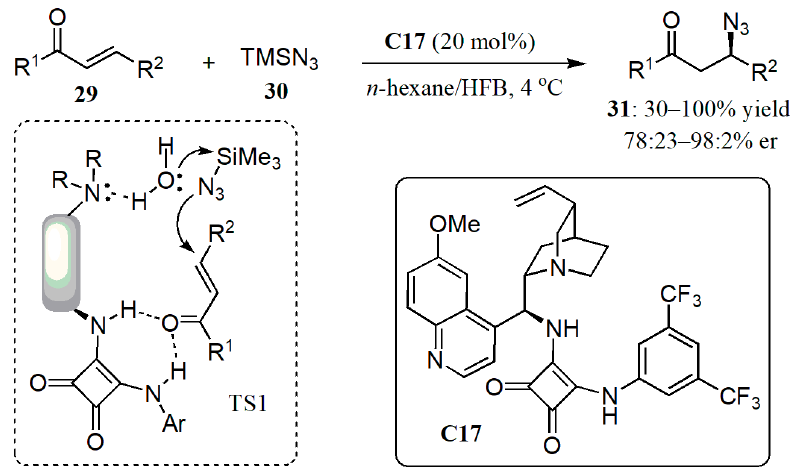
Figure 23. Enantioselective organocatalytic conjugate azidation of α , β -unsaturated ketones with TMSN 3 ; HFB = hexafluorobenzene [52].